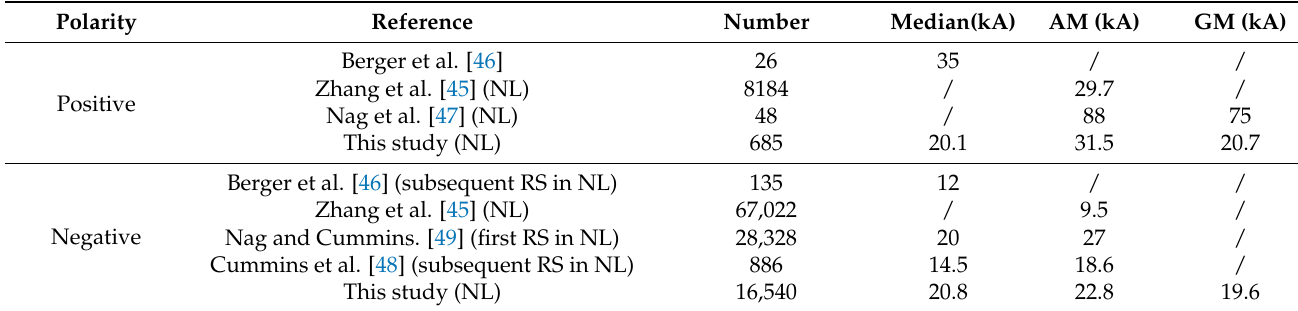
Table 5. Comparison of RS currents among different